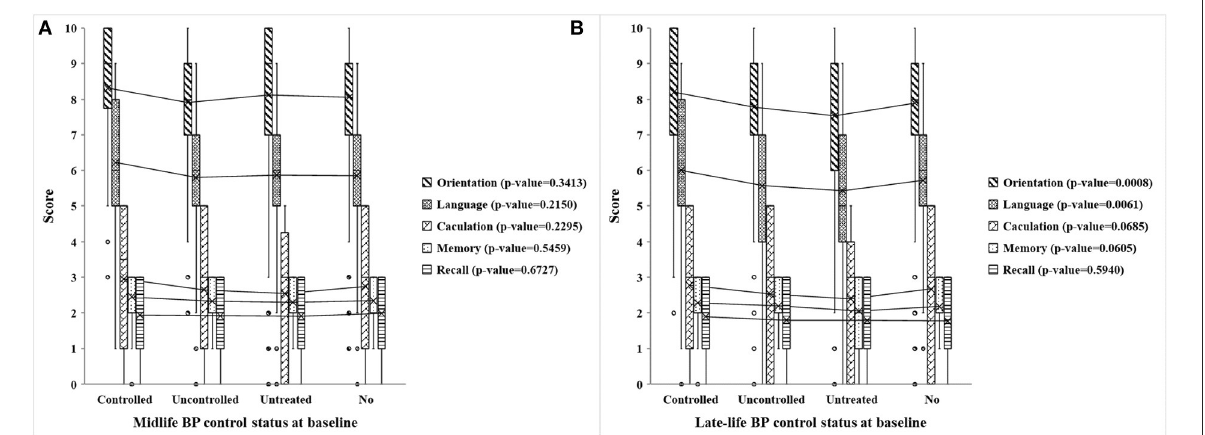
FIGURE2 Scores of five cognitive dimensions in different midlife and late-life BP control statuses at baseline. (A,B) Respectively, show the cognitive scores of five dimensions (including orientation, language, calculation, memory, and recall) in different midlife and late-life BP control statuses at baseline. The midlife BP control status is present in the mid-old group, while the late-life BP control status is present in the old-old group. Controlled, uncontrolled, untreated, no present controlled hypertension, uncontrolled hypertension, untreated hypertension, and no hypertension, respectively. P -value is the analysis of variance of a certain cognitive dimension of four BP control statuses at